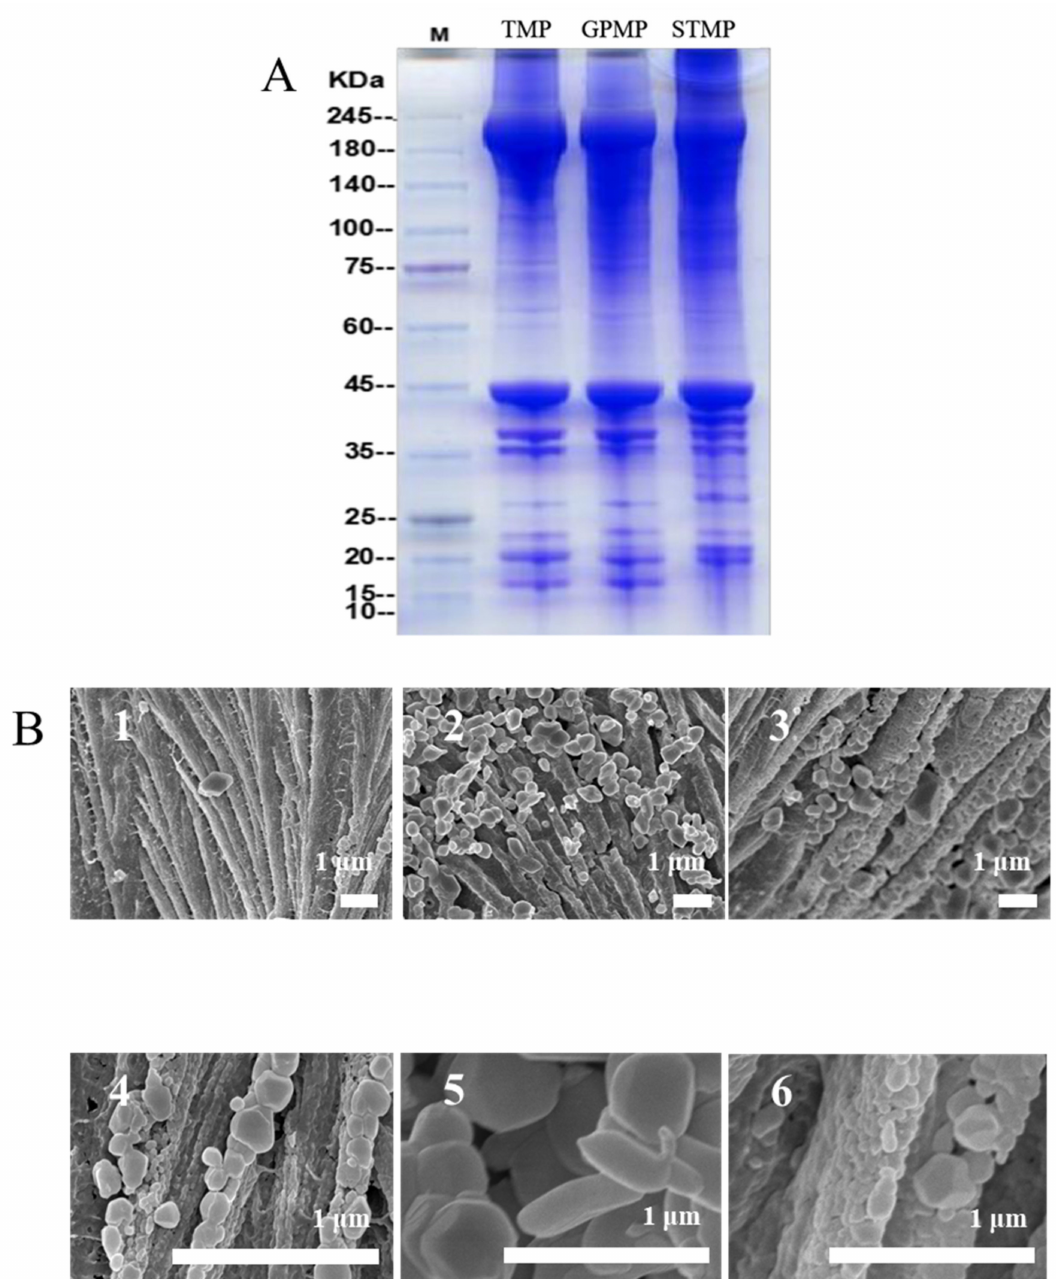
Figure 1. SDS-PAGE electrophoresis ( A ) and the microstructure of MPs observed by scanning electron microscope (SEM) ( B ) (Scale bar = 1 µ m) (( B1 , B4 ) TMP, ( B2 , B5 ) GPMP, ( B3 , B6 ) STMP; ( B1 – B3 ) at the magnification of × 4000, ( B4 – B6 ) at the magnification of ×